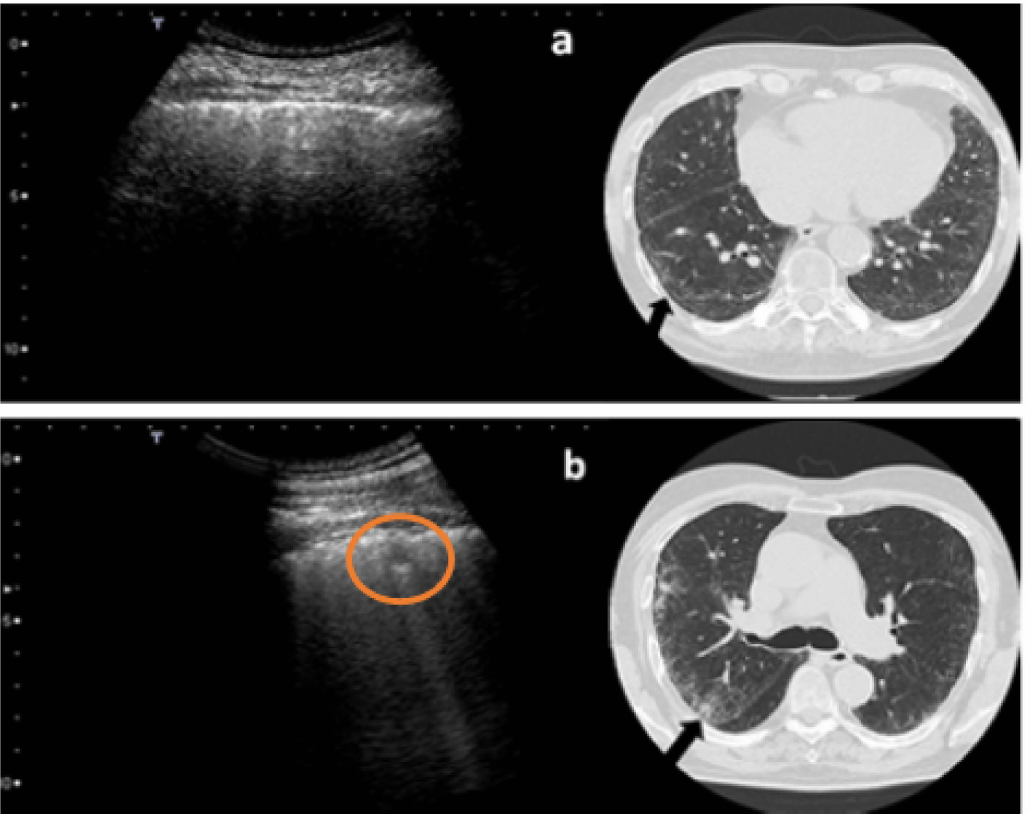
Figure 3. Ultrasound and CT scans of two patients with fibrosing lung disease. The black arrows indicate the position of the probe on the chest. The two CT and ultrasound scans are coplanar. In ( a ) a minor fibrotic involvement is present while in ( b ) a small nodulation (red circle) is